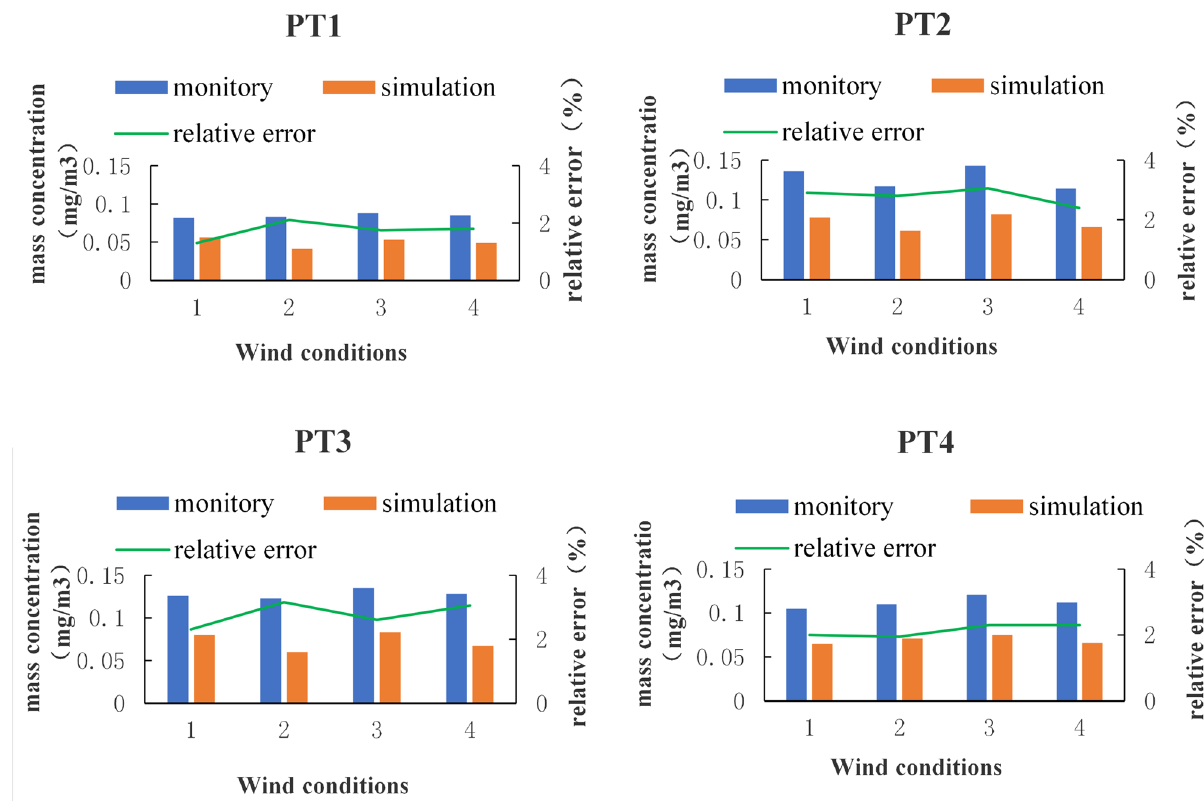
Figure 3. Comparison between simulated and monitored